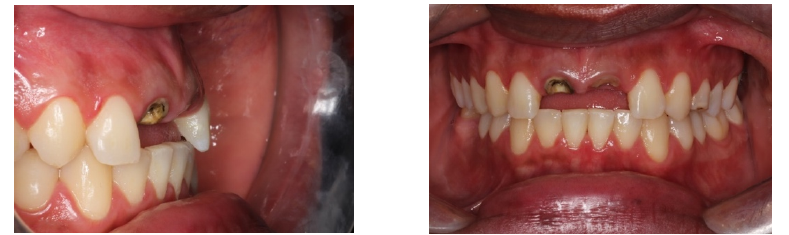
Figure 2. Front and side photo of elements #21 and #11.